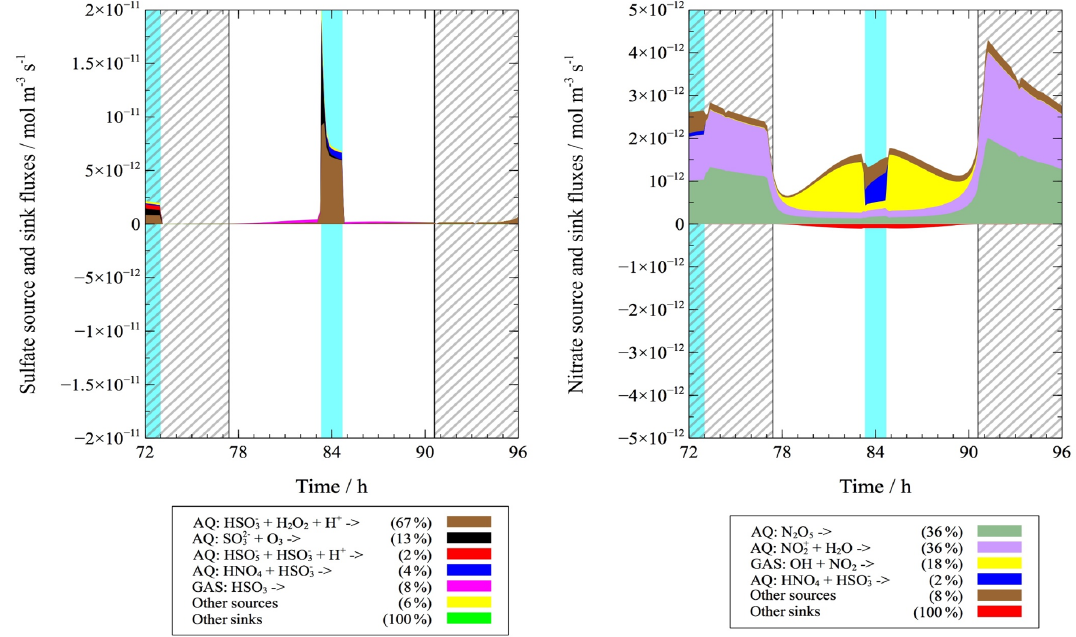
Figure 4. Modeled multiphase (gas + aqueous phase) source and sink fluxes of sulfate and nitrate (light blue column: cloud; shadow: night). Percentage is given for the third model